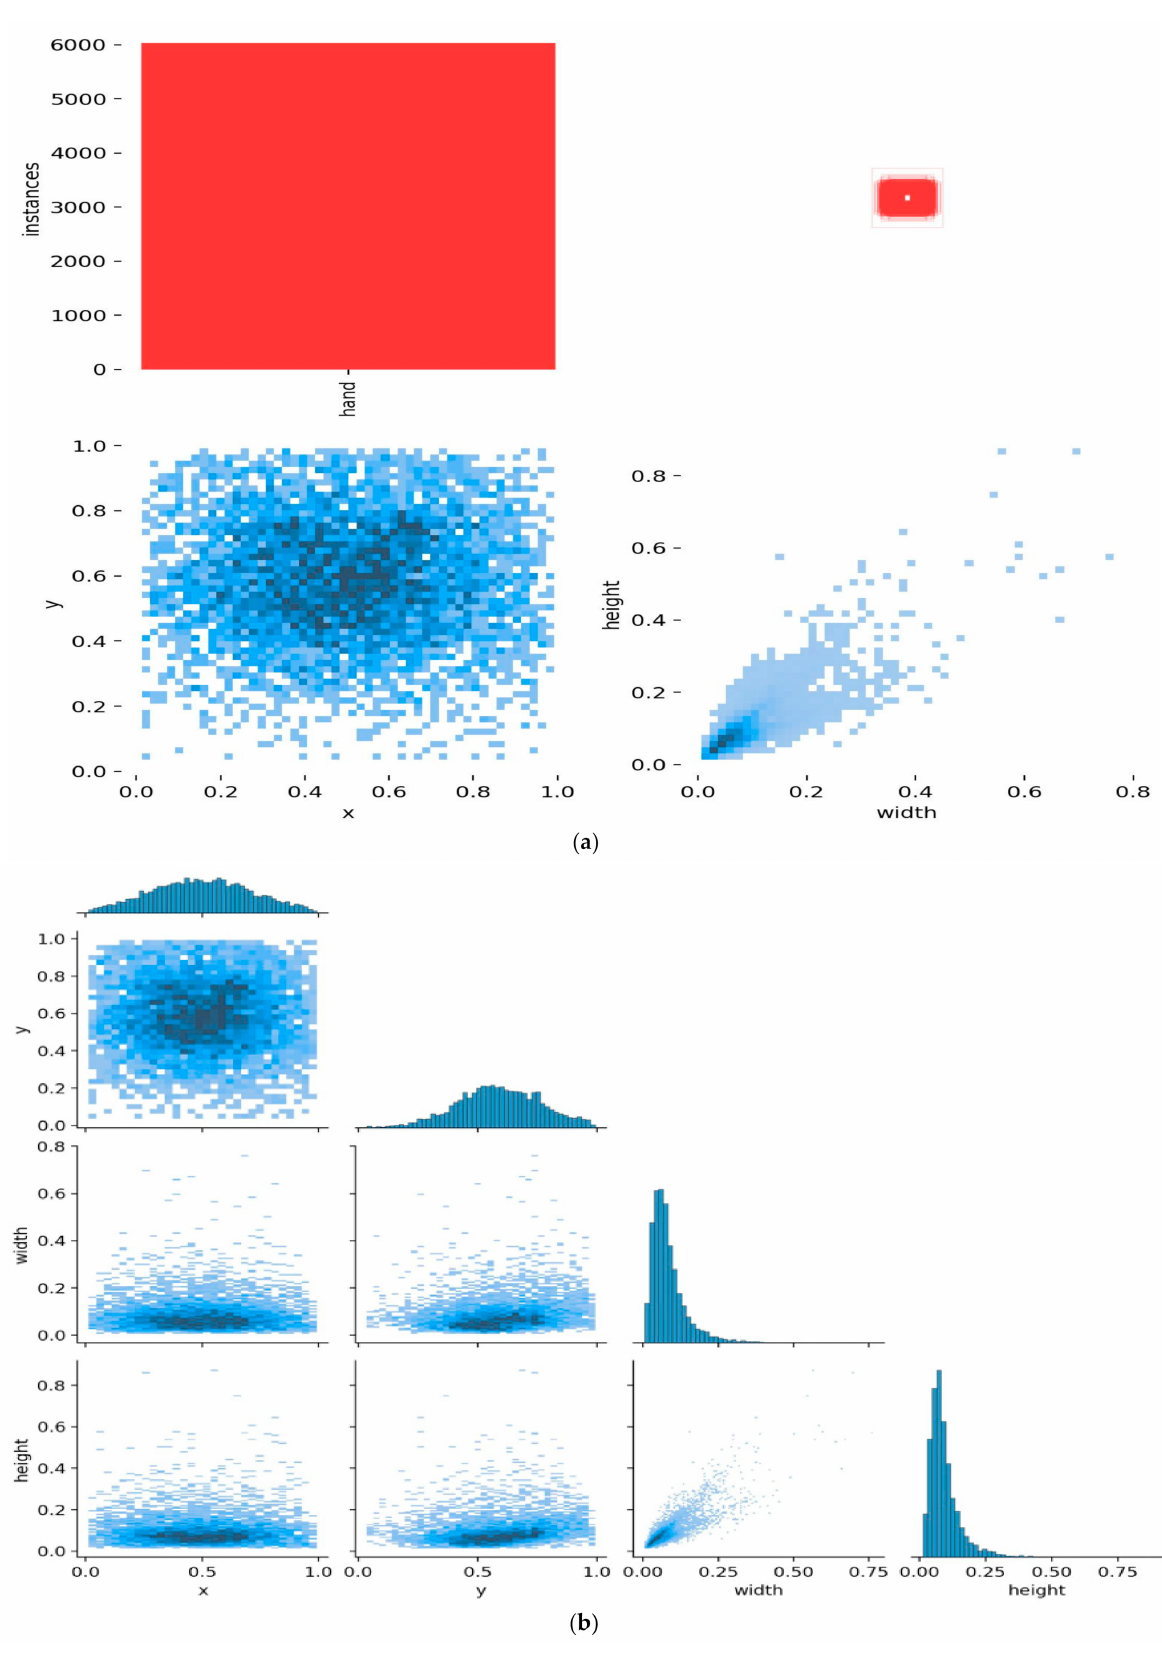
Figure 5. Oxford hand dataset: ( a ) labels and ( b )